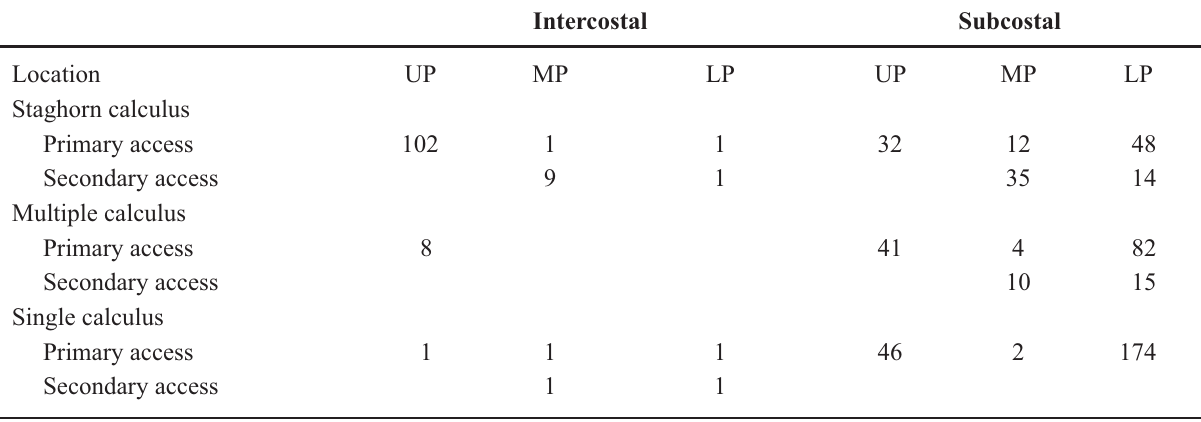
Table 2 – Access by location of calculi.